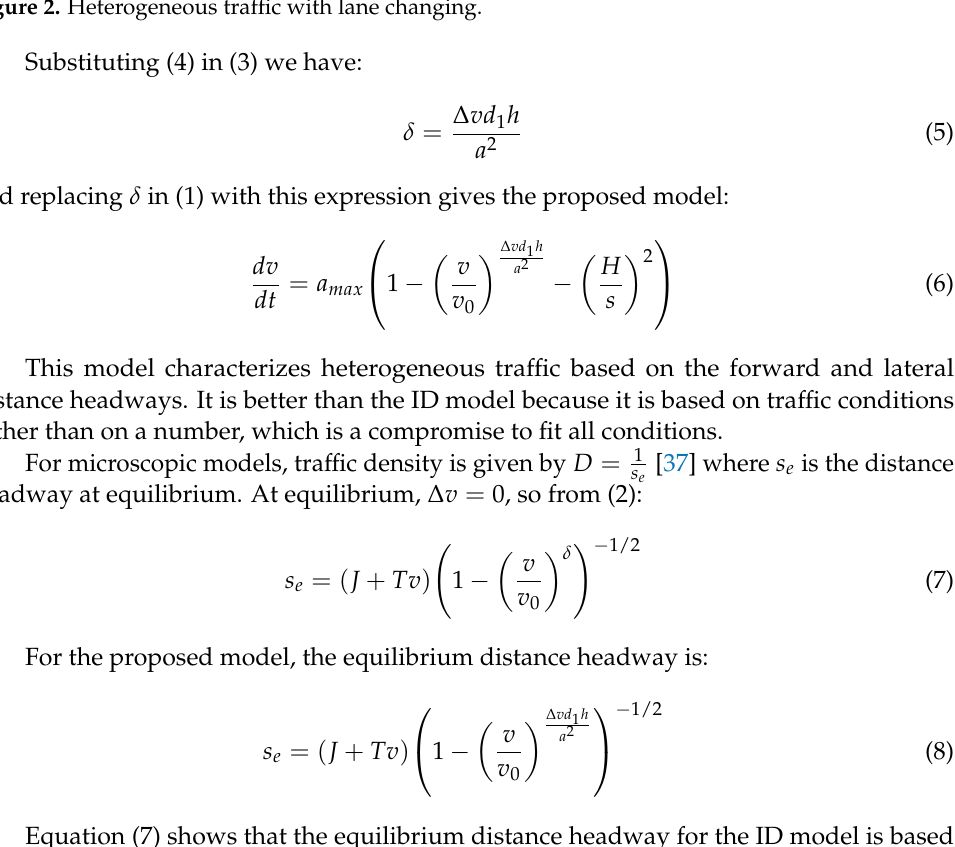
Figure 2. Heterogeneous traffic with lane changing.